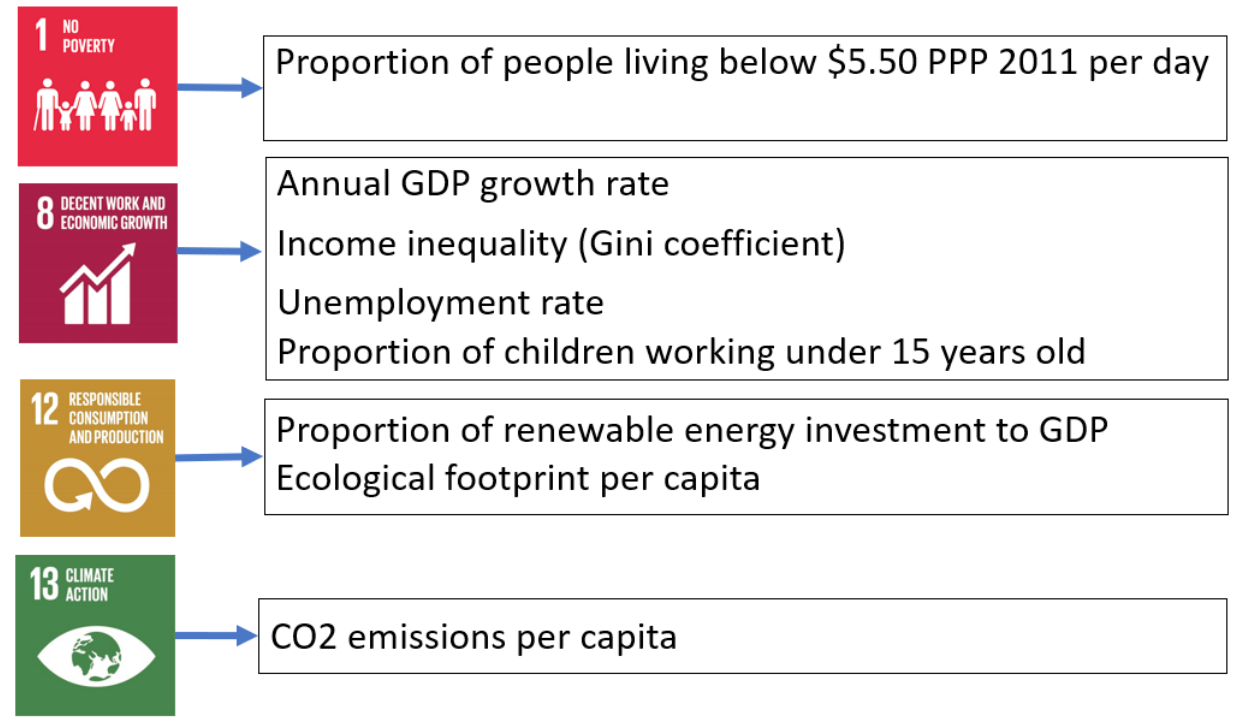
Figure 4. Sets of indicators to measure SDGs in the SDGs